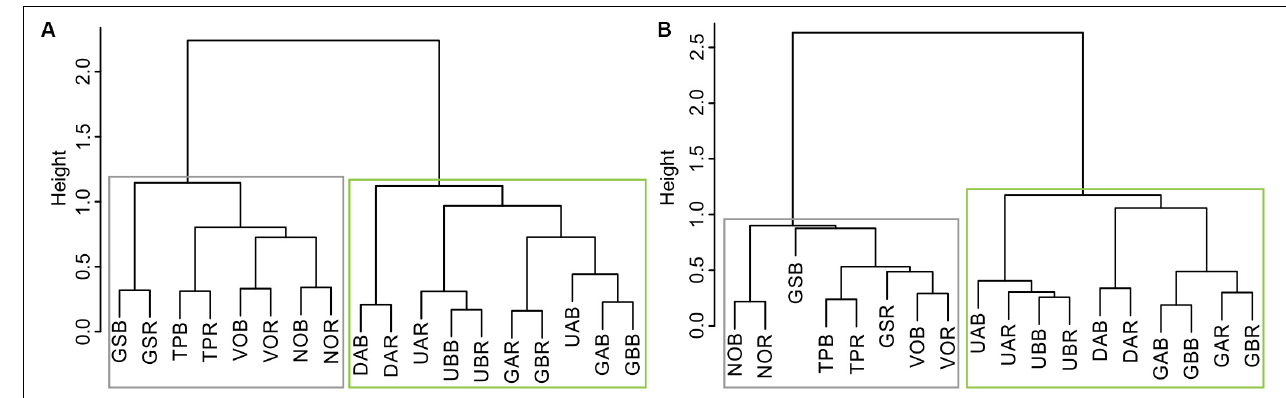
FIGURE 2 | Dendrogram of hierarchical cluster analysis based on microsites: (A) ring-width and (B) latewood blue intensity chronologies over the 1903–2016 period. Boxes represent two sub-regions (gray = north and green = south) in which our microsites were partitioned. The abbreviations of microsite names are explained in Table 1